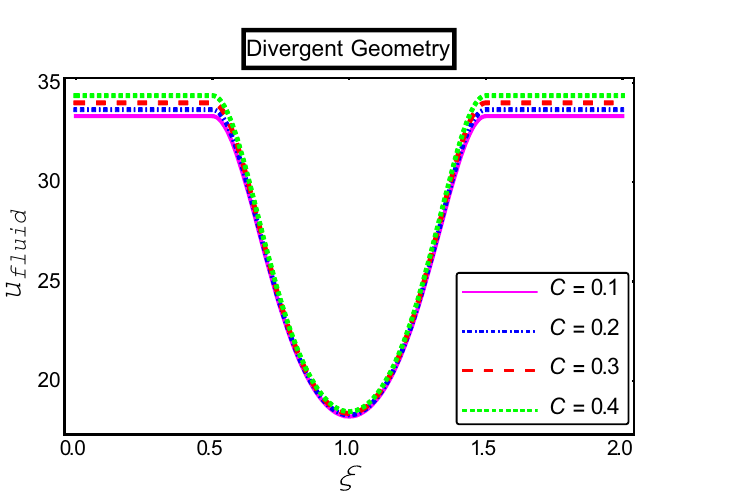
Figure 11. Impact of fluid velocity “ C ” parameters on fluid